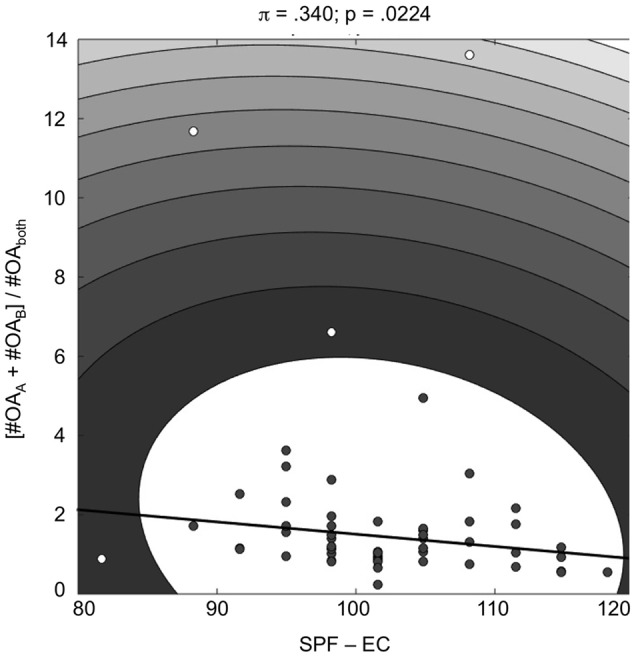
Correlation of the SPF subscale empathic concern (SPF – EC) with decisiveness, i.e., the ratio of unambiguous responses (“person A” or “person B”) to ambiguous responses (“both”), in the other-affective condition ([OAA + OAB]/OAboth). The plot depicts a robust Shepherd’s Pi correlation (Schwarzkopf et al., 2012).